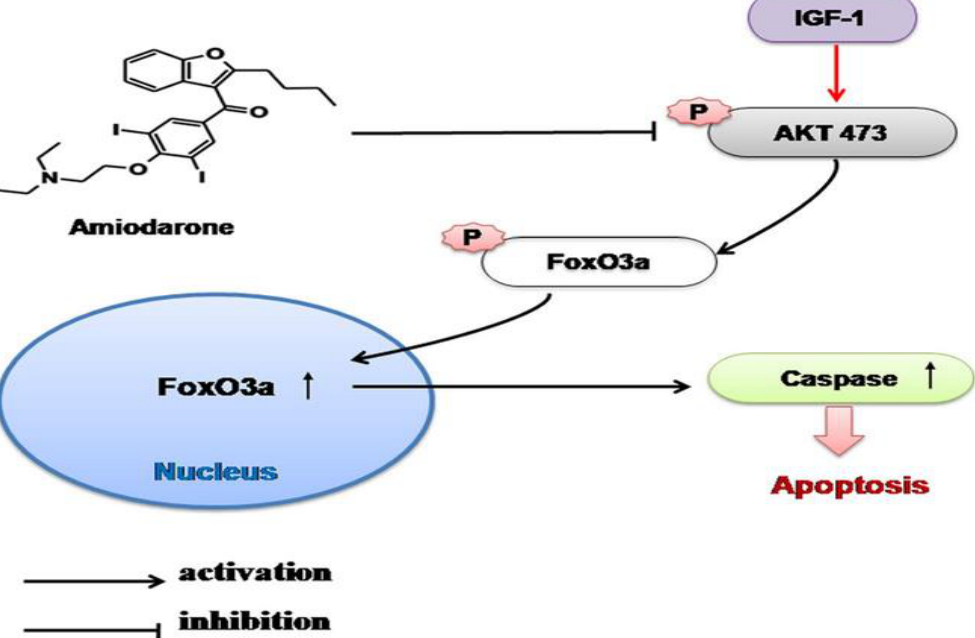
Figure 9. A proposed mechanism of IGF-1 and amiodarone in the RGC. Amiodarone decreases Akt phosphorylation of FoxO3a, leading to nuclear translocation of FoxO3a and increased caspase mediated apoptosis. IGF-1 antagonizes amiodarone by stimulating Akt phosphorylation of FoxO3a, leading to increased cytosolic localization and improved RGC survival [40].